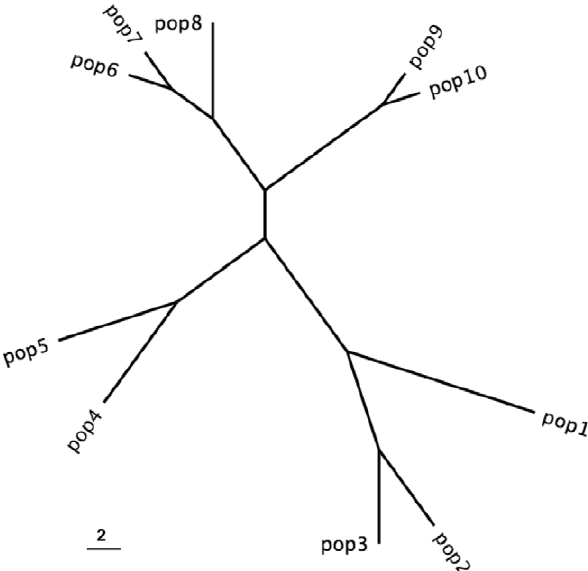
Figure 5. NJ tree of the studied populations based on ISSR data.